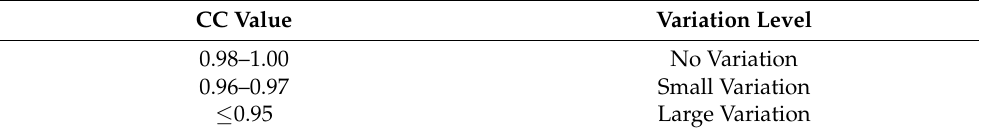
Figure 7. The proposed methodology for fault extent using the correlation coefficient (CC). Table 2. CC benchmark limits and level of